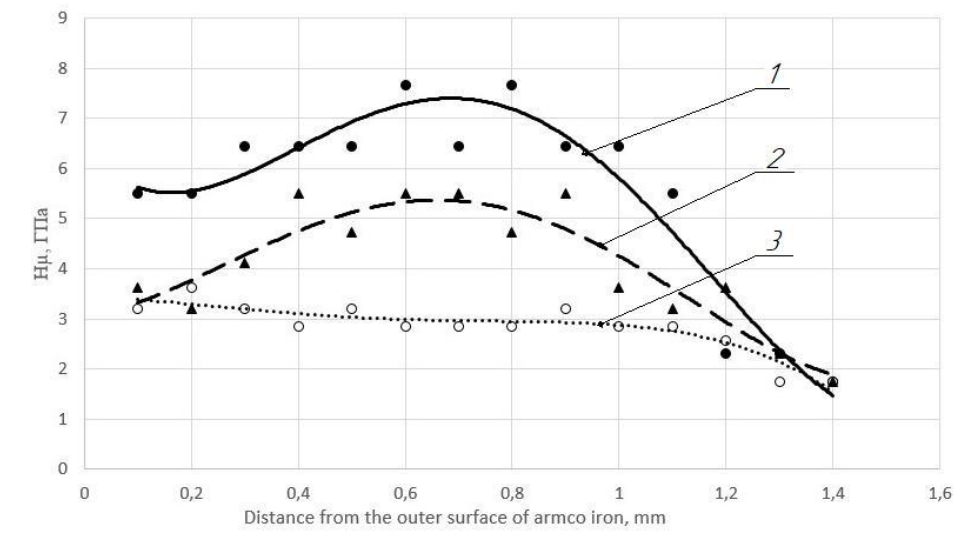
Fig. 4. Distribution of the microhardness of the cross-section of the fusion nucleus of two steel plates: 1) in the presence of carbon nanofibers between them; 2) in the presence of carbon nanotubes and powder vanadium between them 3) in the presence of vanadium powder